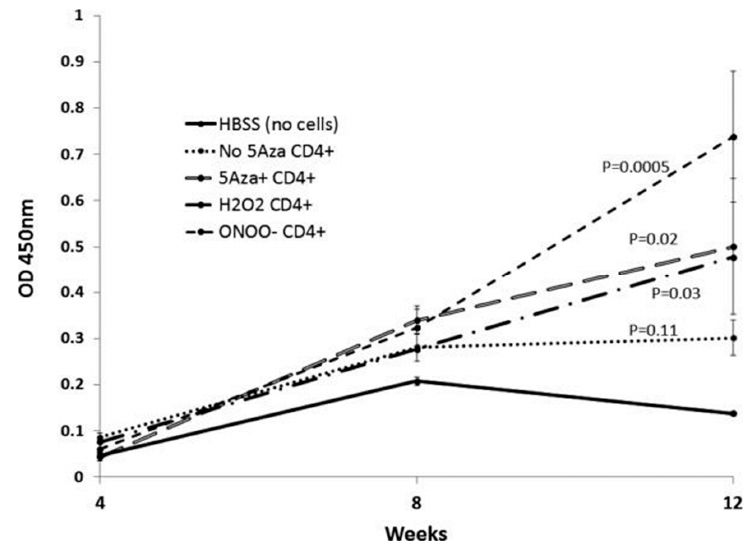
Figure 1. Splenocytes from SJL mice were stimulated with concanavalin A, treated as indicated, then injected into syngeneic recipients every two weeks for a total of seven injections. Anti-dsDNA antibodies were measured by enzyme-linked immunosorbent assays (ELISA) at the indicated weeks. The Y axis shows the optical density (OD) of the ELISA. Cells 2019 , 8 , x